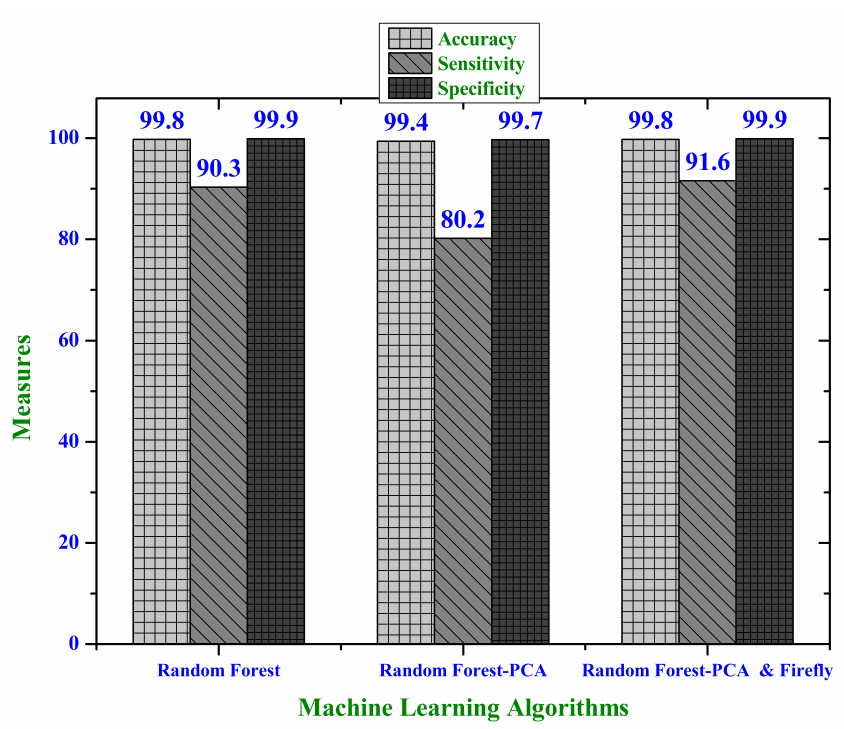
Figure 6. Performance evaluation of random forest classifier.